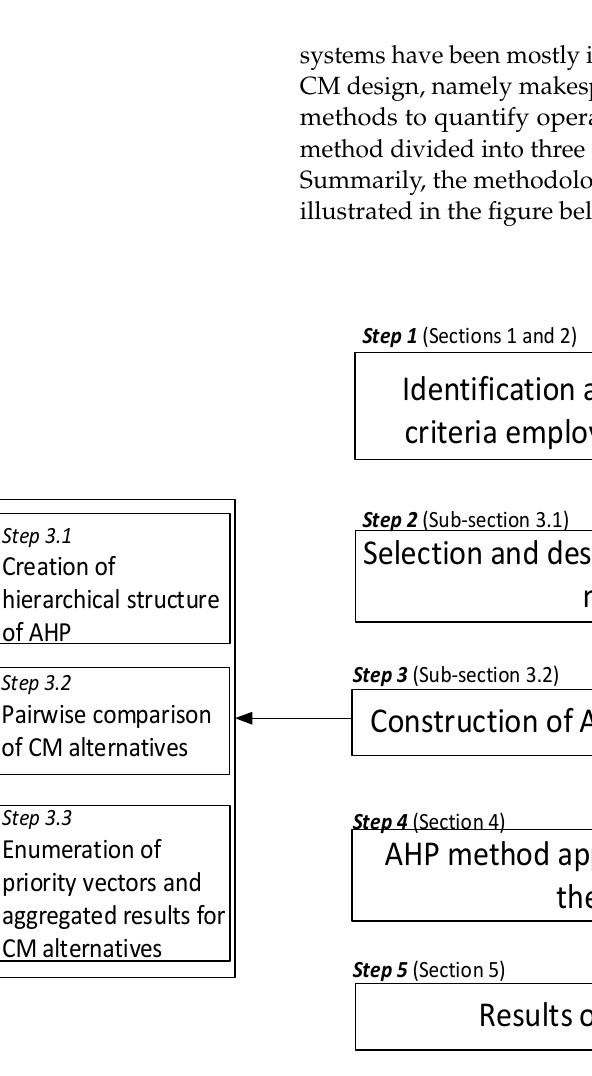
Figure 1. Overall research procedure in chronological order (Sections 1–5).